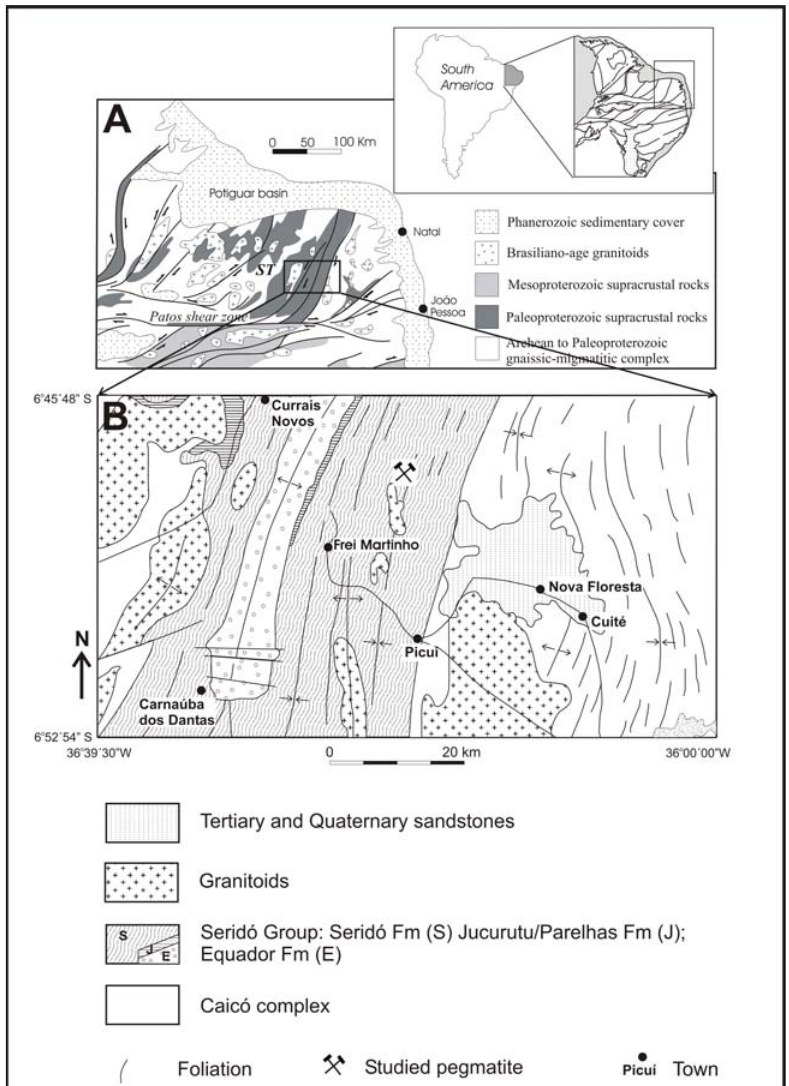
Fig. 1 – Location of the Borborema province in northeastern Brazil (insert of A); (A) geological sketch of the Seridó foldbelt; (B) location of the Alto Quixaba pegmatite, intruded into biotite schists of the Seridó Formation of the Seridó Group. Geological units shown in (B) are from E.F. Jardim de Sá (unpublished